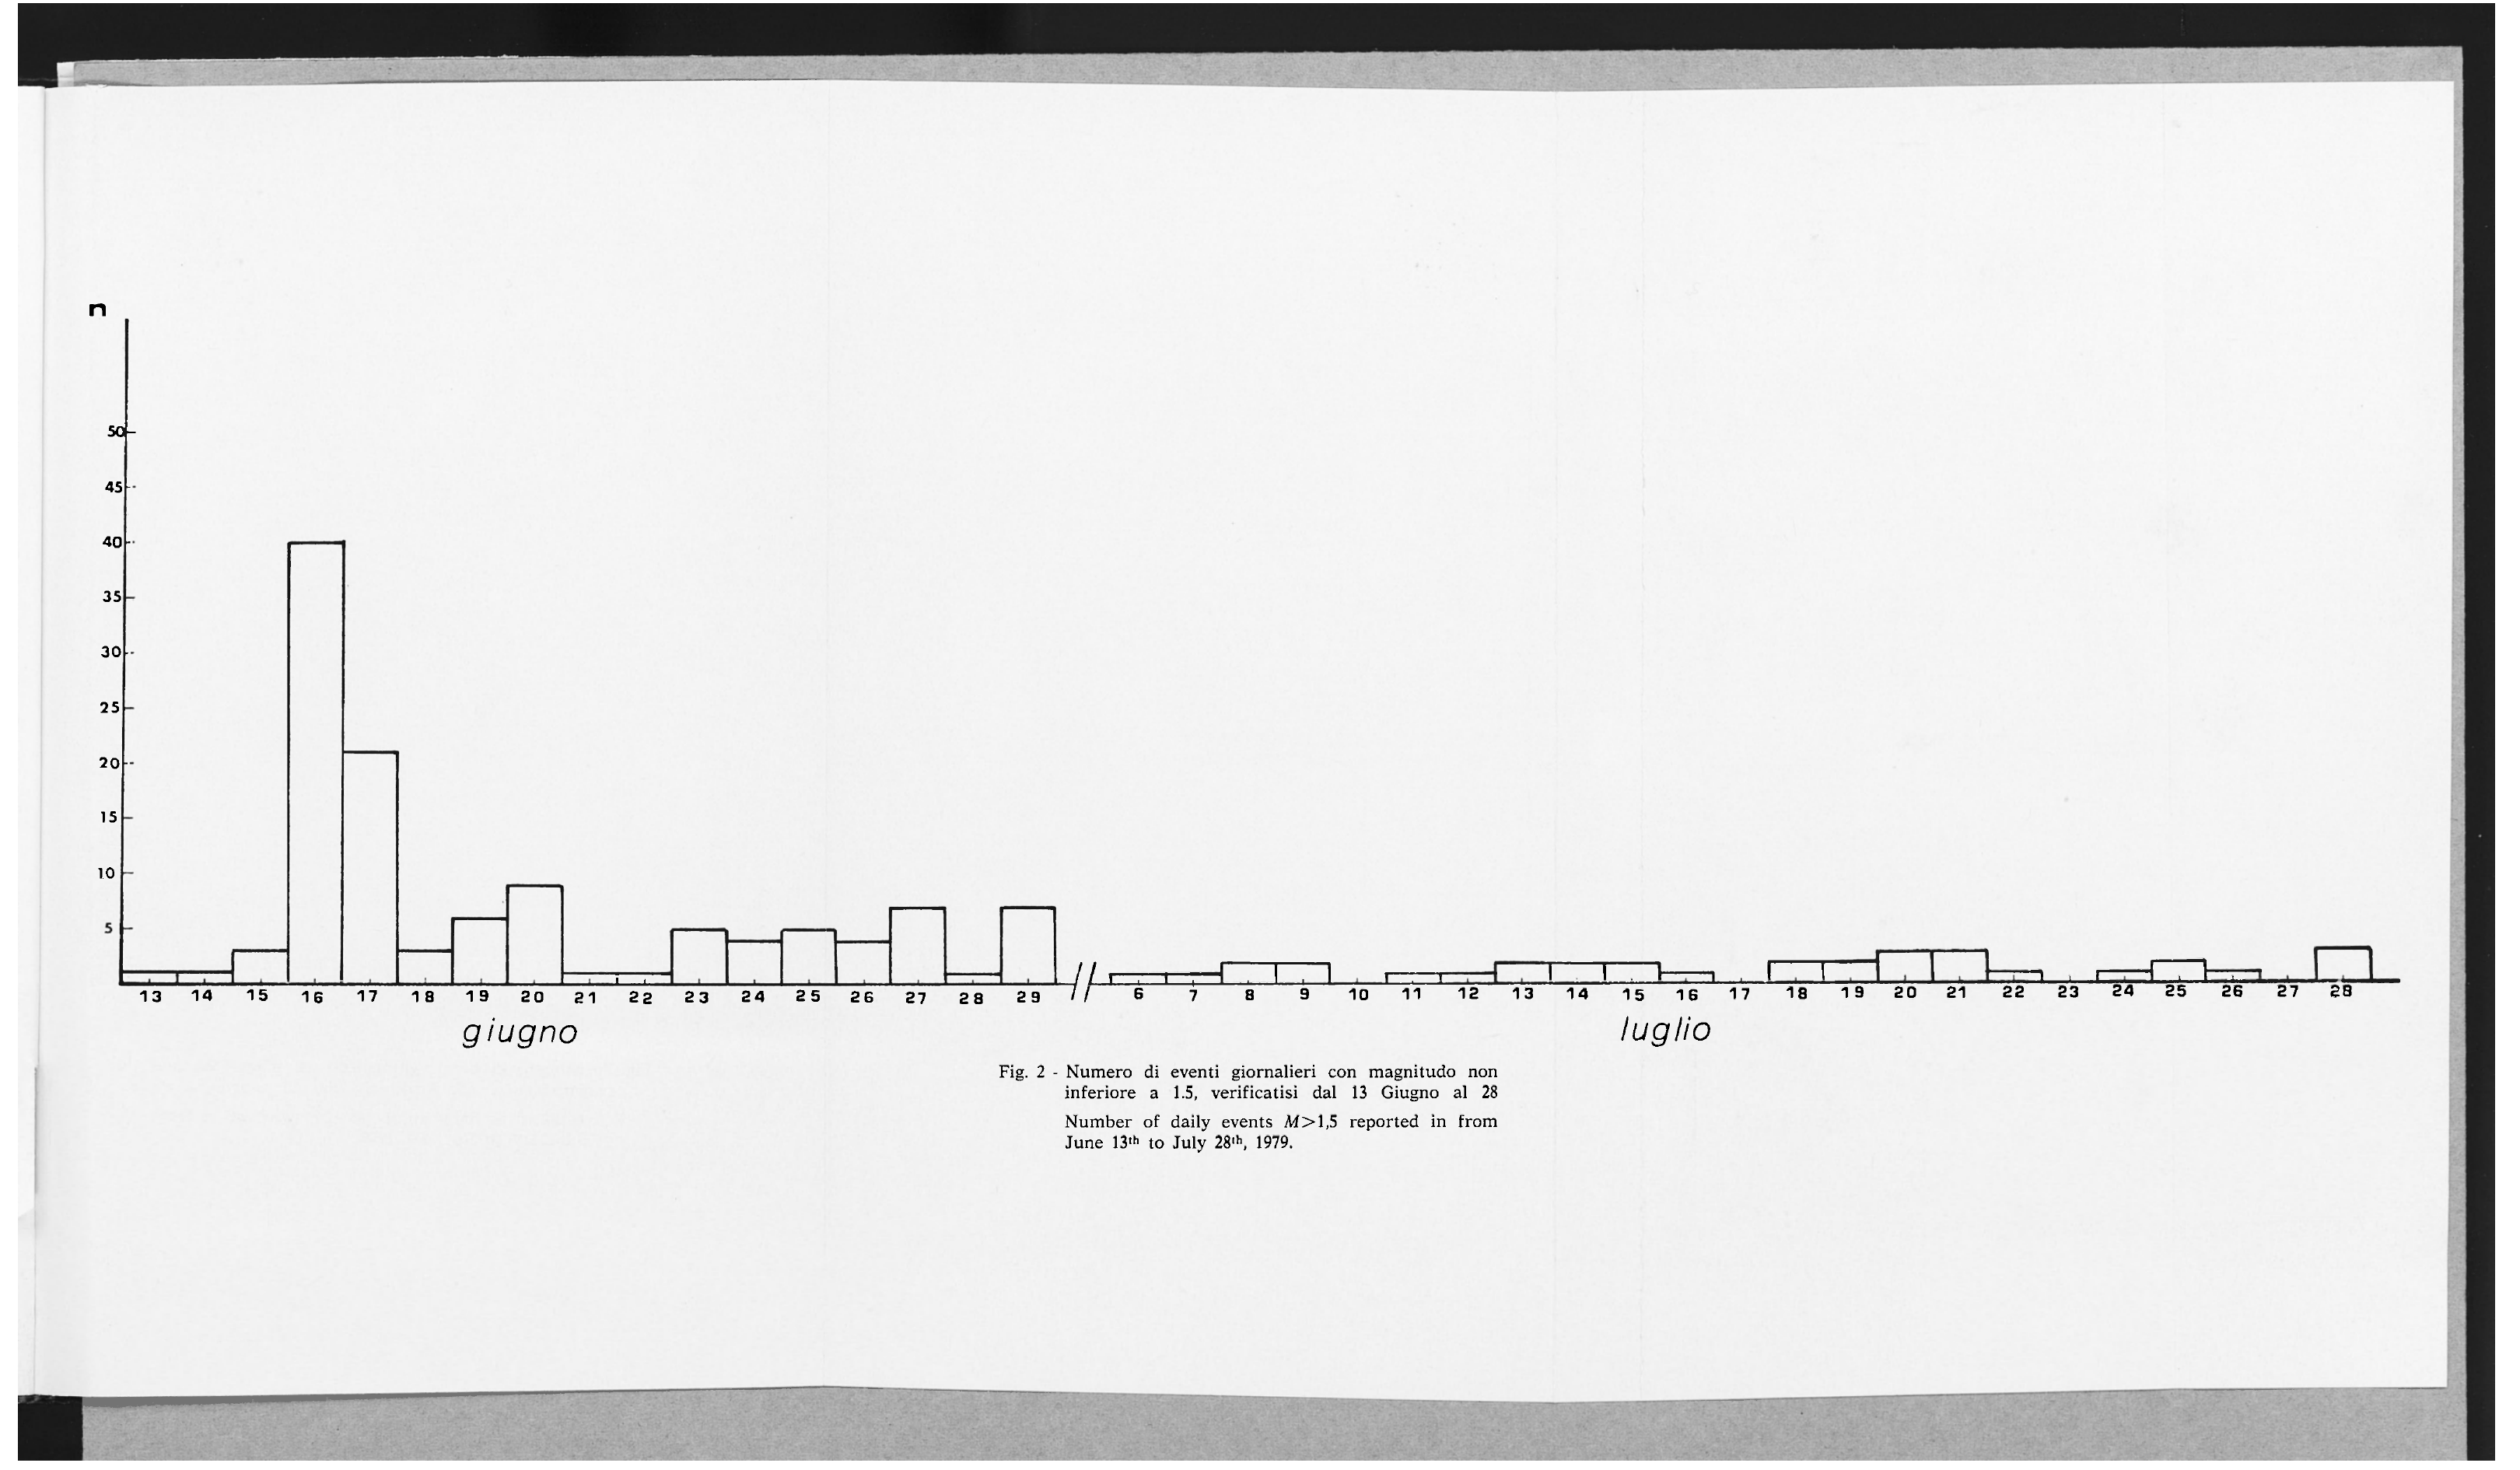
Fig. 2 - Numero di eventi giornalieri con magnitudo non inferiore a 1.5, verificatisi dal 13 Giugno al 28 Number of daily events M>1,5 reported in from June 13'h to July 28'",